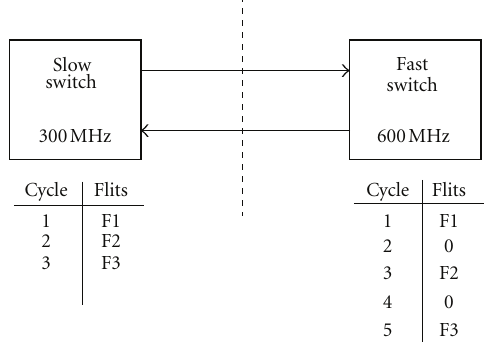
Figure 1: Bubbles generated moving from slow to fast